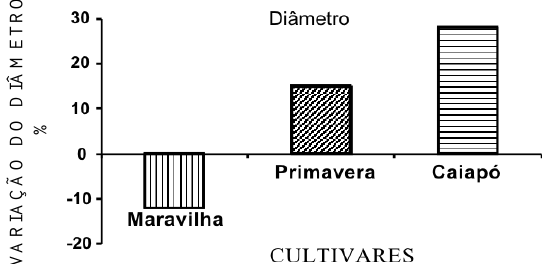
Figura 2. Variação em percentagem do diâmetro radicular entre os tratamentos que receberam a menor e a maior dose de boro aplicado no